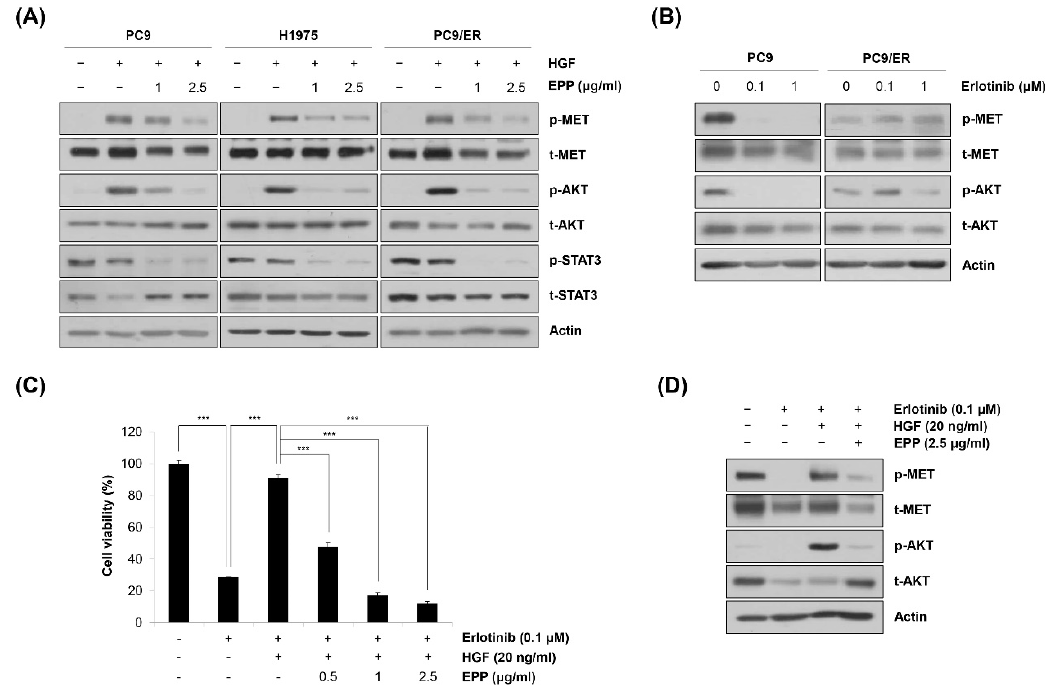
Figure 5. Blockage of MET by EPP in human NSCLC cell lines with different EGFR mutation statuses. ( A ) PC9, H1975, and PC9/ER human NSCLC cells were pretreated with 1 μ g/mL or 2.5 μ g/mL EPP for 24 h and stimulated with HGF (20 ng/mL) 30 min before harvest. Phosphorylated and total MET, AKT, and STAT3 proteins were detected via Western blot analysis. Representative images of duplicate experiments are shown. ( B ) PC9 and PC9/ER cells were treated with 0.1 μ M or 1 μ M erlotinib for 24 h. Phosphorylated and total MET and AKT proteins were detected via Western blot analysis. Representative images of duplicate experiments are shown. ( C ) PC9 cells were pretreated with EPP (0.5–2.5 μ g/mL) for 2 h followed by co-treatment with erlotinib (0.1 μ M) and HGF (20 ng/mL) for 72 h. Cell viability was measured using the MTT assay. The data are ex- pressed as the mean ± SD of triplicate experiments. Significance was determined using Student’s t - test (*** p < 0.001 vs. respective control). ( D ) PC9 cells were co-treated with EPP (2.5 μ g/mL) and erlotinib (0.1 μ M) for 24 h and stimulated with HGF (20 ng/mL) 30 min before harvest. Phosphory- lated and total MET and AKT proteins were detected using Western blot analysis. Representative images of duplicate experiments are shown. EPP, the root extract of Peucedanum praeruptorum Dunn; NSCLC, non-small-cell lung cancer; EGFR, epidermal growth factor receptor; HGF, hepato- cyte growth factor; STAT3, signal transducer and activator of transcription 3. 2.6. Identification of Specific Compounds Contributing to the Anticancer Effect of EPP High-performance liquid chromatography–mass spectrometry (HPLC-MS) analysis was conducted to identify praeruptorin A (PA), a coumarin generally found in the roots of PP, in EPP [29]. The total chromatograms of PA and EPP were acquired at 330 nm via UV detection. We found that the peak of PA was detected at a retention time of 25.95 min (Supplementary Figure S2 and Table 1). The chromatogram of EPP also included a peak at a retention time of 25.94 min. Moreover, the molecular weight of the EPP peak detected via MS analysis was the same as that of PA at m / z 404.1 [M + H] + , indicating that PA was contained in EPP (Supplementary Figure S2 and Table 1). As PA can be used for the stand- ardization of the PP root, our results demonstrate that a standardized PP specimen was used in this study. Table 1. The HPLC-MS data of PA and EPP peak. Name